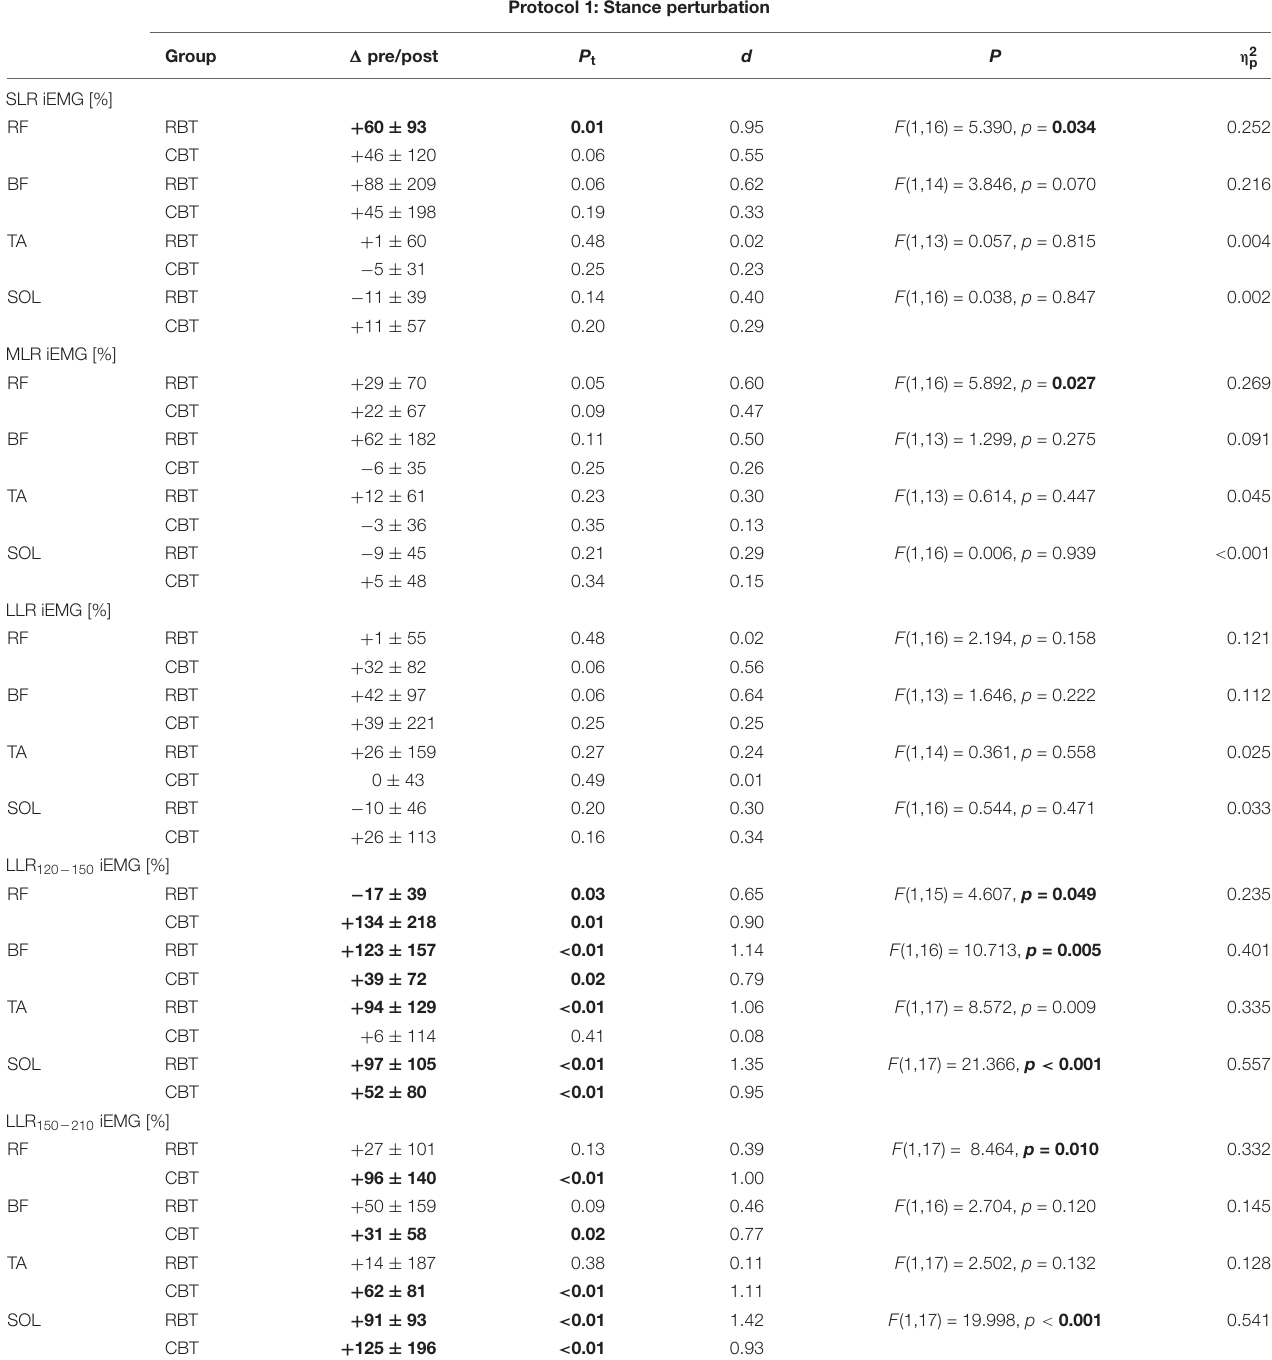
Protocol 1: Stance